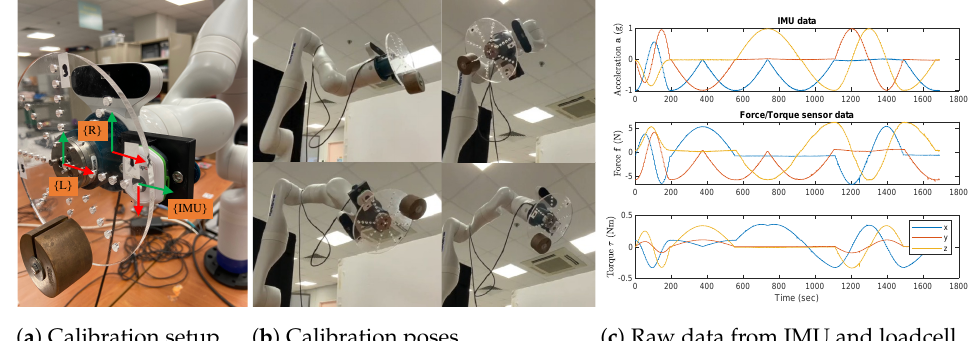
Figure A1. ( a ) The calibration setup consisted of the loadcell. ( b ) The calibration setup was held by a robot at several static poses, as shown, to obtain synchronous data from both sensors ( c ) The IMU data show the true effect of gravity on the calibration rig and was used to compute the expected forces to calibrate the forces recorded by the loadcell, also